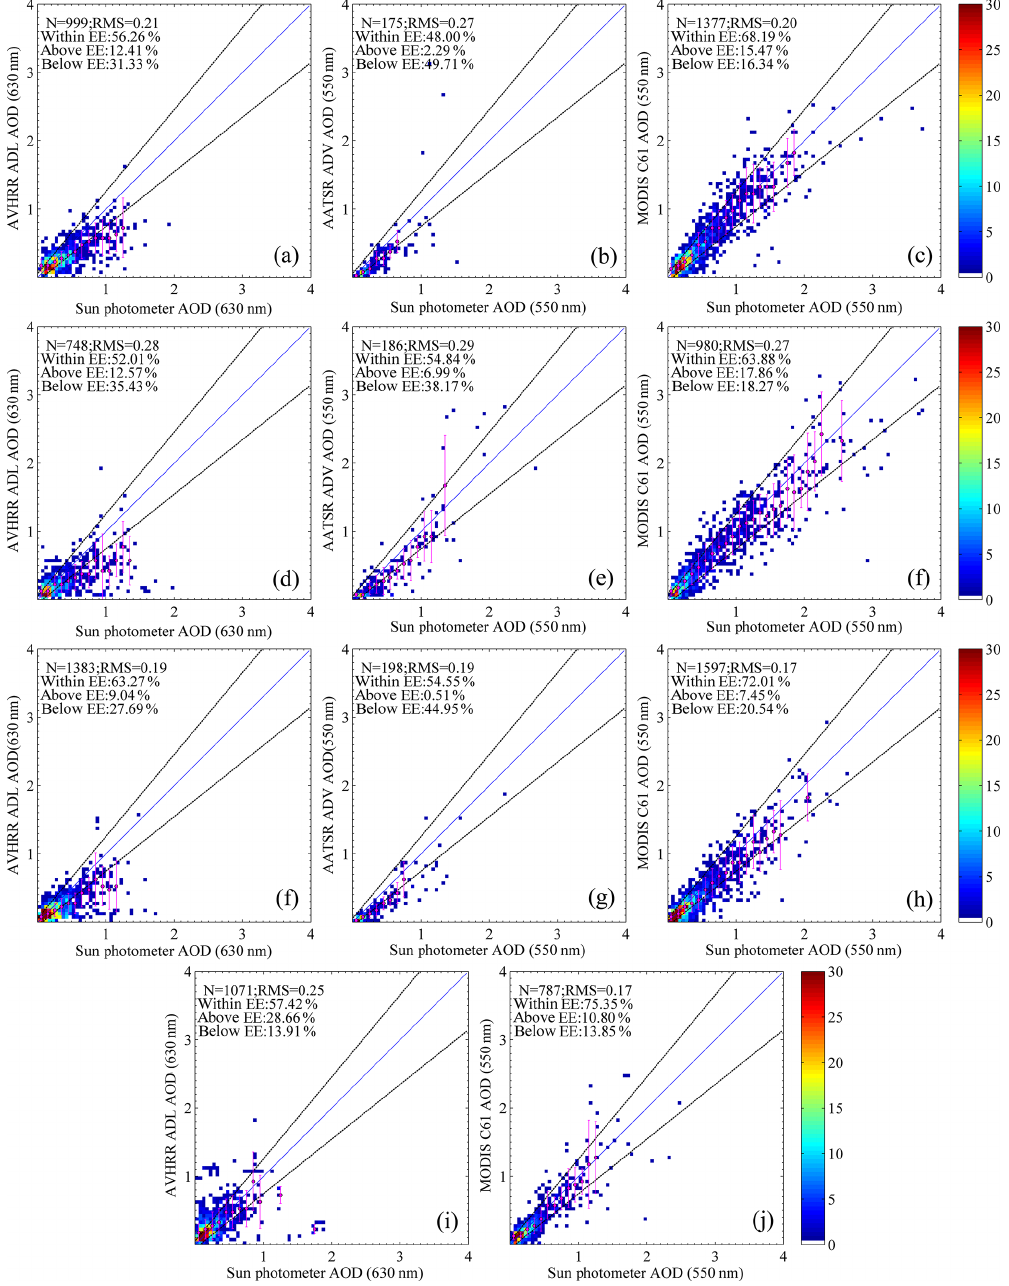
Figure A1. Seasonal scatter density plots of satellite-retrieved AOD vs. sun-photometer-retrieved AOD. Panels (a) , (d) , (f) and (i) are AVHRR AOD vs. AERONET AOD in spring, summer, autumn and winter. Panels (b) , (e) and (g) are ATSR AOD vs. AERONET AOD in spring, summer and autumn. Panels (c) , (f) , (h) and (j) are MODIS AOD vs. AERONET AOD in spring, summer, autumn and